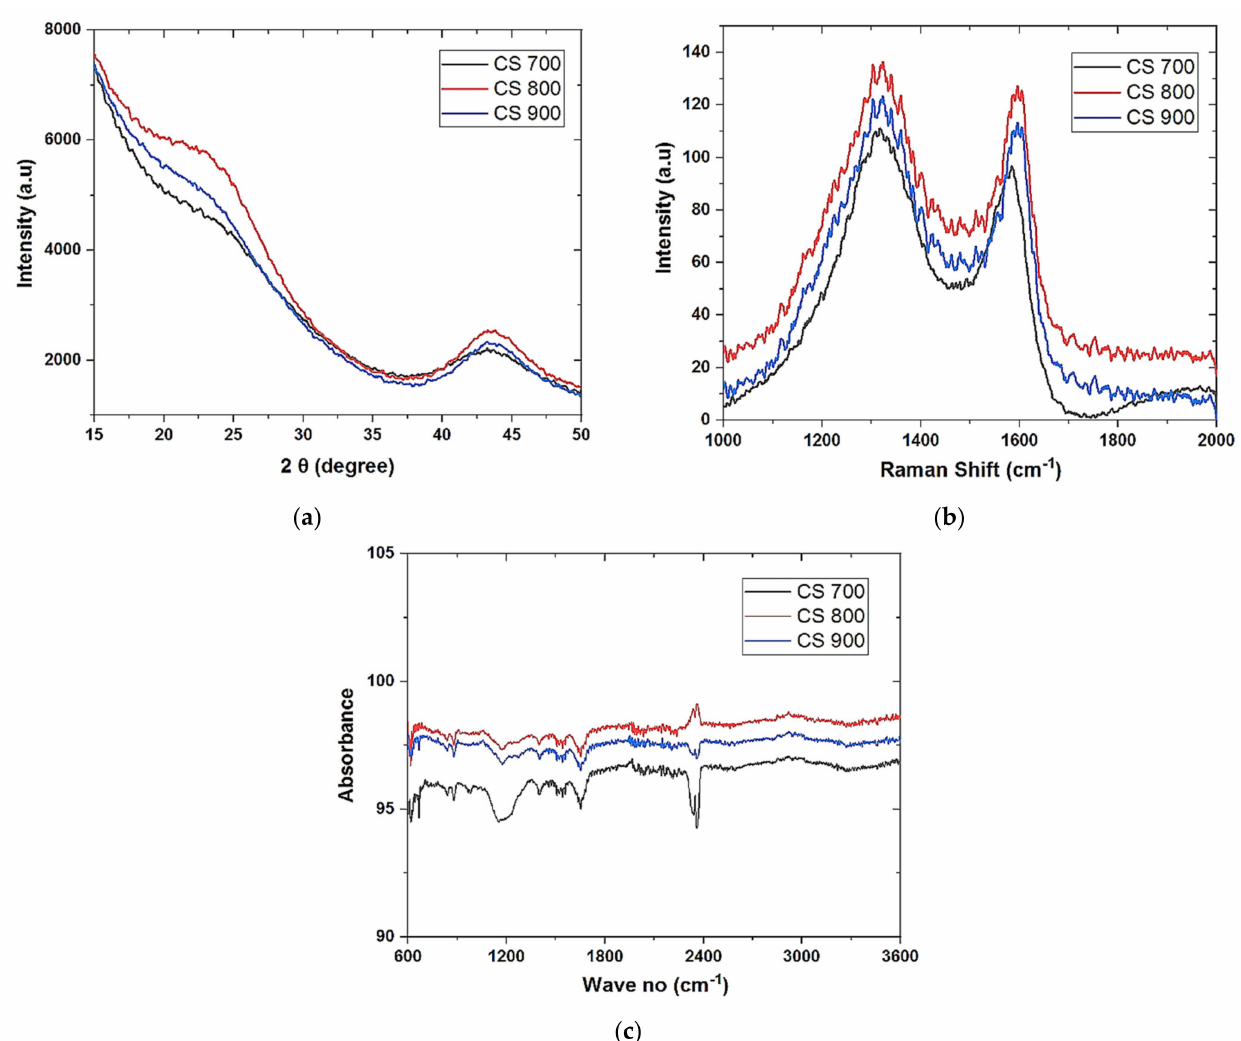
Figure 2. XRD ( a ) CS 700, CS 800, and CS 900; ( b ) Raman spectra of CS 700, CS 800, and CS 900; ( c ) FTIR of CS 700, CS 800, and CS